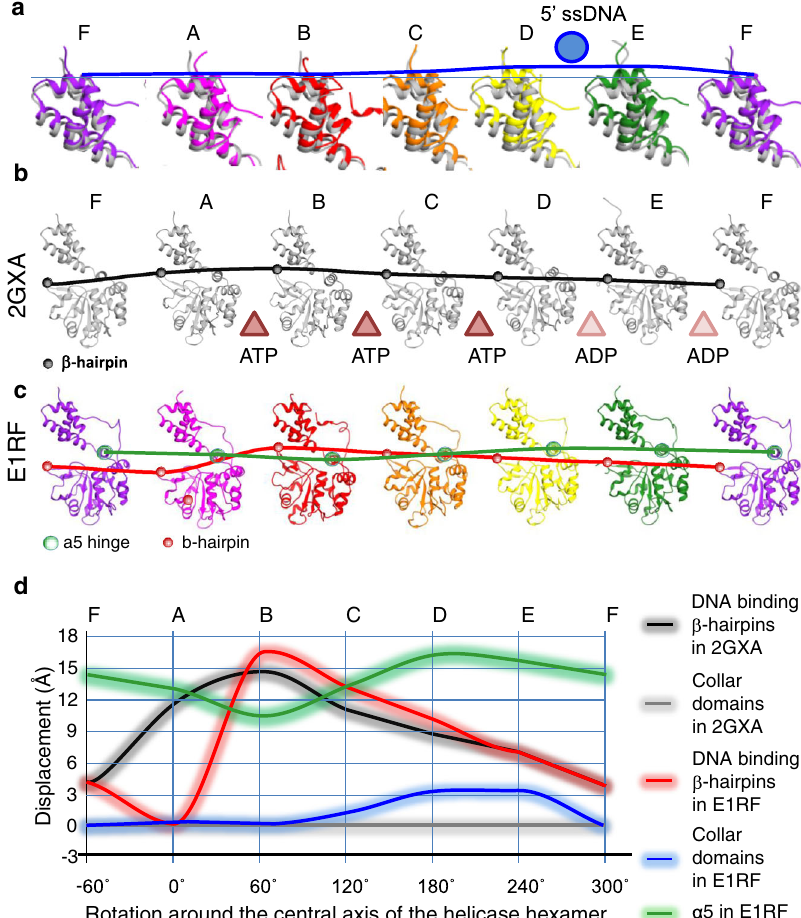
Fig. 7 Positional variation of the subunit domains in E1RF. a A tiled representation of the atomic models of the E1RF collar domains (rainbow) overlaid with the corresponding domains of the E1HD/ssDNA/ADP X-ray structure (in grey). The blue curve indicates the collar domain shifts in the EM structure compared to the X-ray structure, which reaches a maximum under the 5 ’ ssDNA (blue circle). b A black curve traces the shifts in the DNA-binding β - hairpins in the X-ray structure; nucleotide states at the subunit interfaces are indicated with brown (ATP) or pale brown (ADP) triangles. c Curves tracing the movement of the α 5 hinge (green) and DNA binding β -hairpins (red) in E1RF. d Graphical representation of the displacements of the collar domains, the β -hairpins and the α -5 hinge point of the E1RF subunits relative to the corresponding subunits in the X-ray structure. The accuracy of the measurements is indicated by the thickness of the